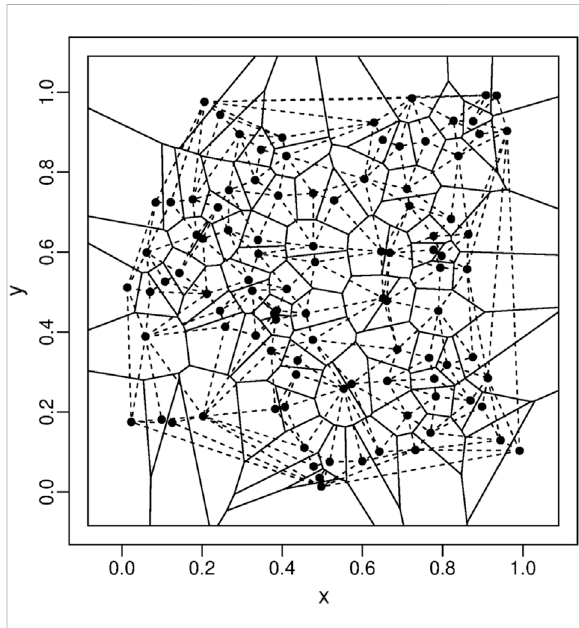
FIGURE 1 Voronoi tessellation of n =100 uniformly distributed points (black dots) bounded by the unit square and the convex hull of points; edges of the PV cells (solid lines) and Delaunay triangulation associated with the Voronoi diagram (dashed